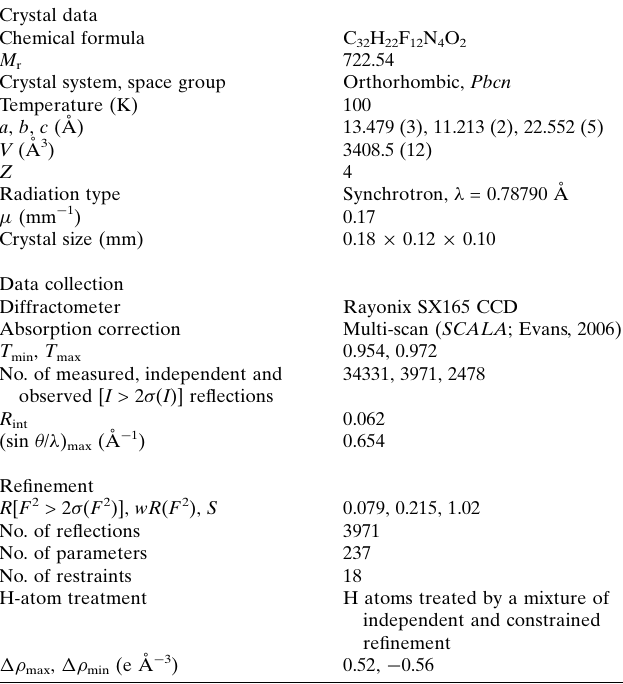
The fluorine atoms of the C15F three orientations in a 0.6: 0.2: 0.2 ratio. Within the disordered